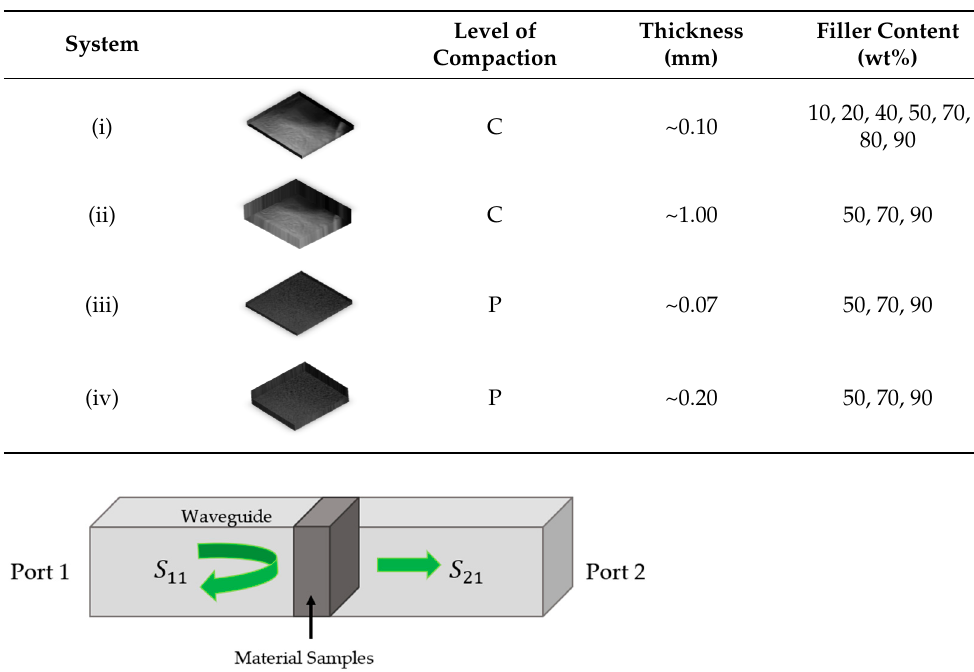
Figure 2. Rectangular waveguide measurement setup.